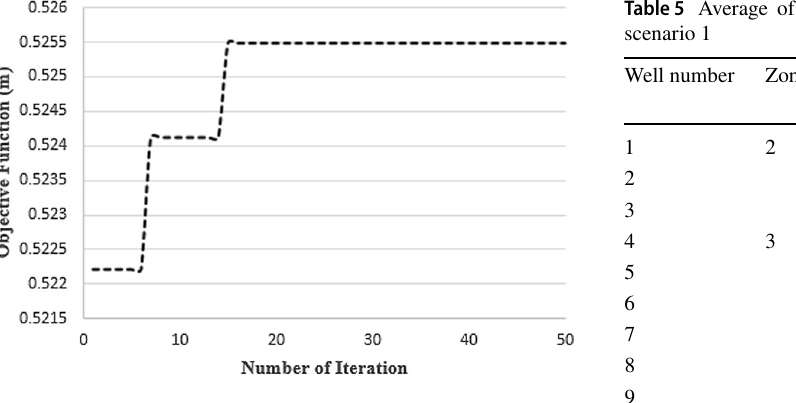
Fig. 6 The convergence process of simulation–optimization model IGA-GWO under scenario 1